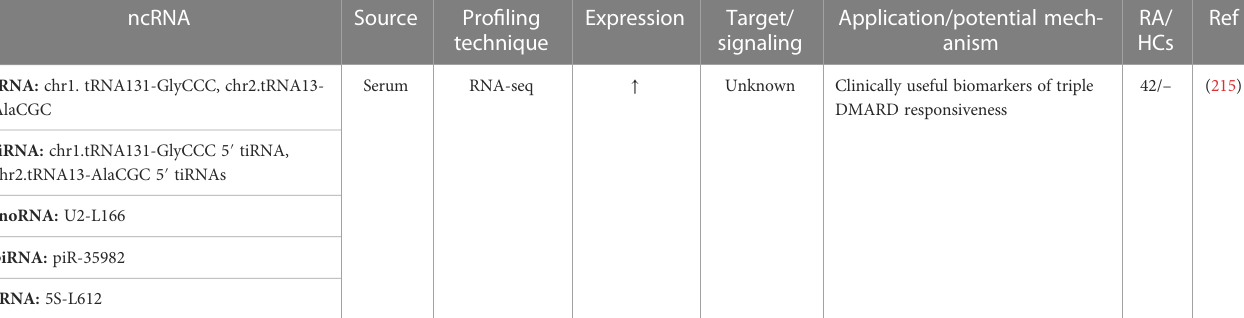
TABLE 5 Potential tRNA, tiRNA, snoRNA, piRNA, and rRNA biomarkers for